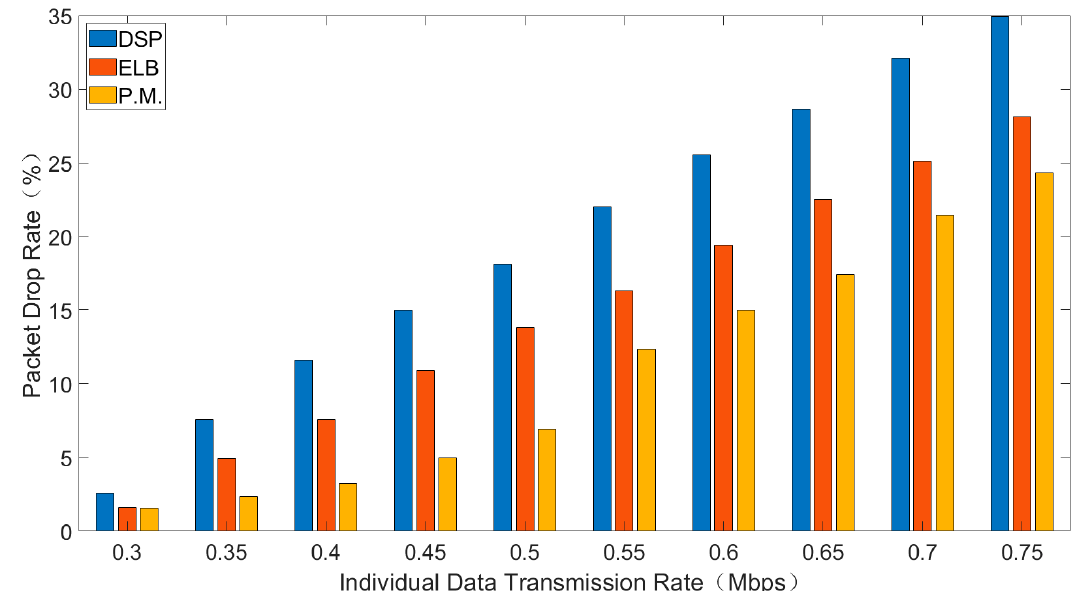
Figure 6. The packet drop rate for different sending rates.